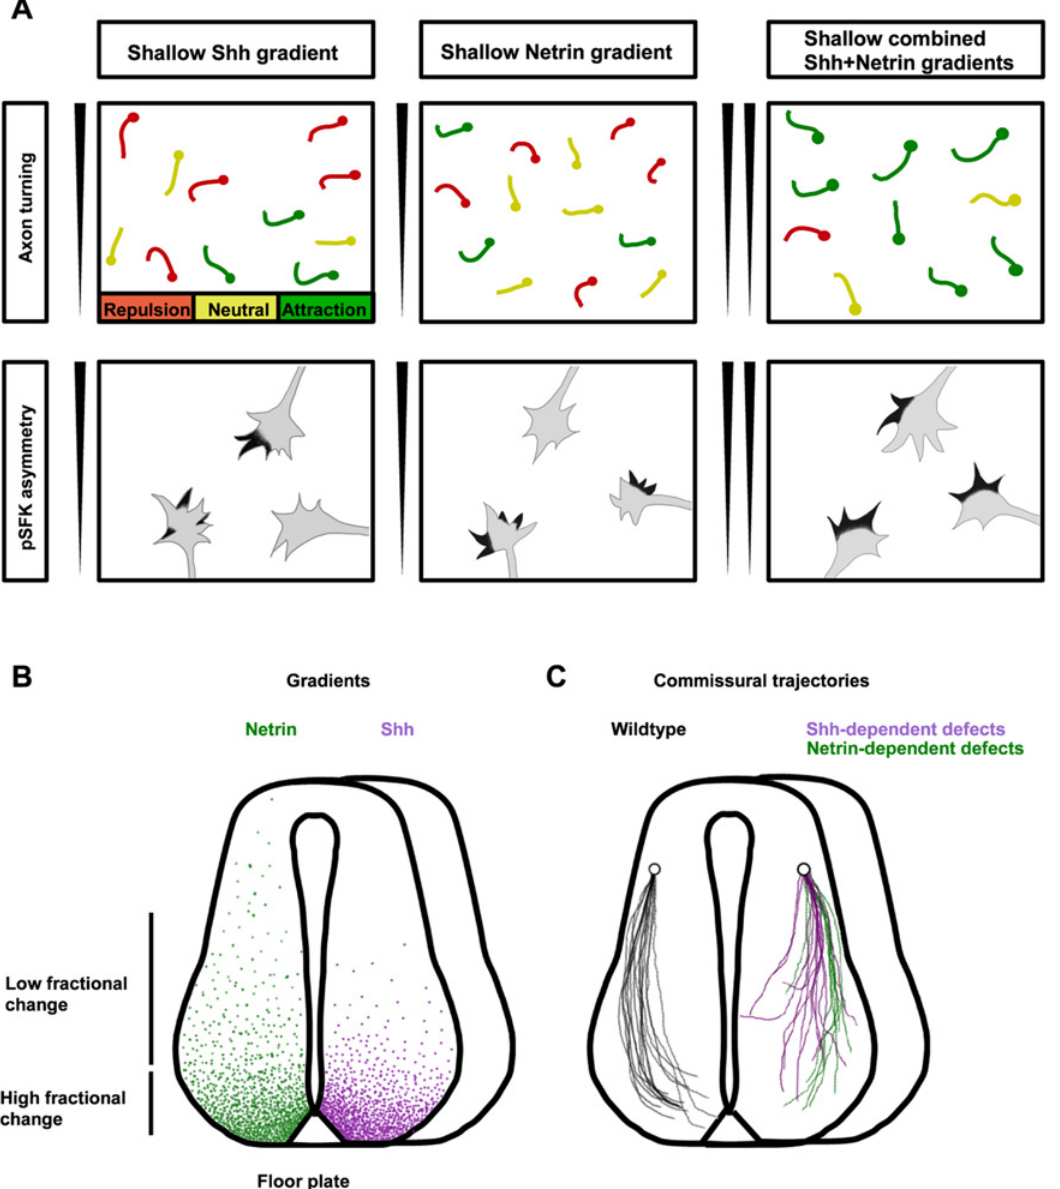
Fig 7. Shh and Netrin-1 synergize to guide commissural axons when their gradients are shallow. (A) In shallow individual cue gradients, commissural axon turning is random (left and middle). In the presence of combined Shh and Netrin-1 shallow gradients (right), axons turn toward the higher concentration of guidance cue. When either gradient alone is insufficient to promote axon turning, pSFK activation is also not polarized up the gradient. However, the combined Shh and Netrin-1 gradient biases pSFK distribution to the side of the growth cone facing up the gradient. (B) In the developing spinal cord, the gradients of Shh and Netrin-1 proximal to the floor plate are steep (high fractional change), whereas further from the floor plate, the gradients of Shh and Netrin-1 are shallow (low fractional change). (C) When either the Shh or Netrin-1 signaling pathway is disabled, guidance errors occur at approximately the midpoint of the spinal cord, where the gradients are shallow. Our results suggest that in this shallow gradient region, integrating multiple guidance cues is necessary for correct growth cone